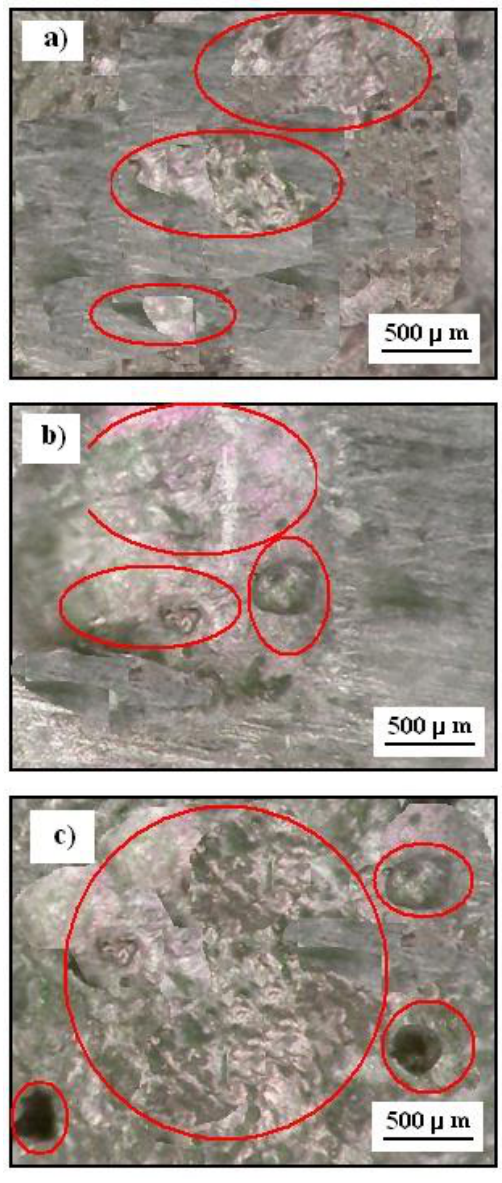
Figure 12. MO images of the Cr 3 C 2 -25(Ni20Cr) cermet coatings on the Al7075 substrate after laser remelting for the spot speed: ( a ) 600. mm/min, ( b ) 800 mm/min, and ( c ) 1000 mm/min in 1.2 M Cl − , pH 1.5. Exposure time was five hours. (Corrosion damages are marked in red).